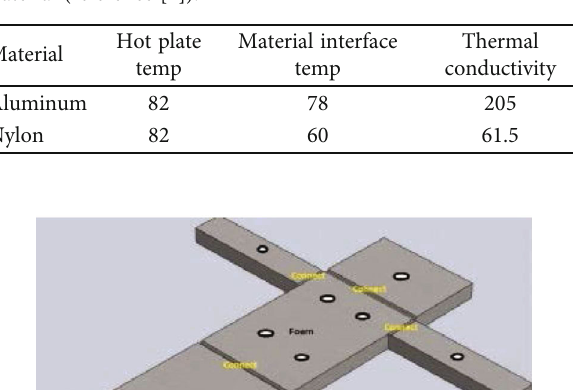
Figure 1: Experimental setup of aluminum and nylon (reference [4]). Table 3: Temperatures taken with thermocouple for di ff erent material (reference [4]).